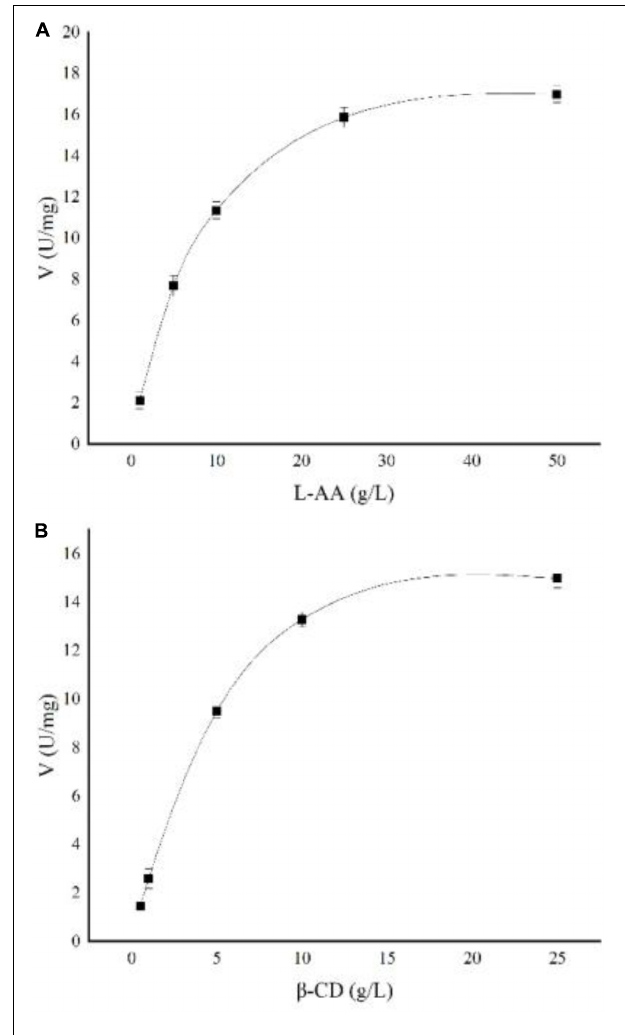
FIGURE 7 | Nonlinear regression of AA-2G synthesis by recombinant CGTase. (A) L -AA, (B) β -CD.